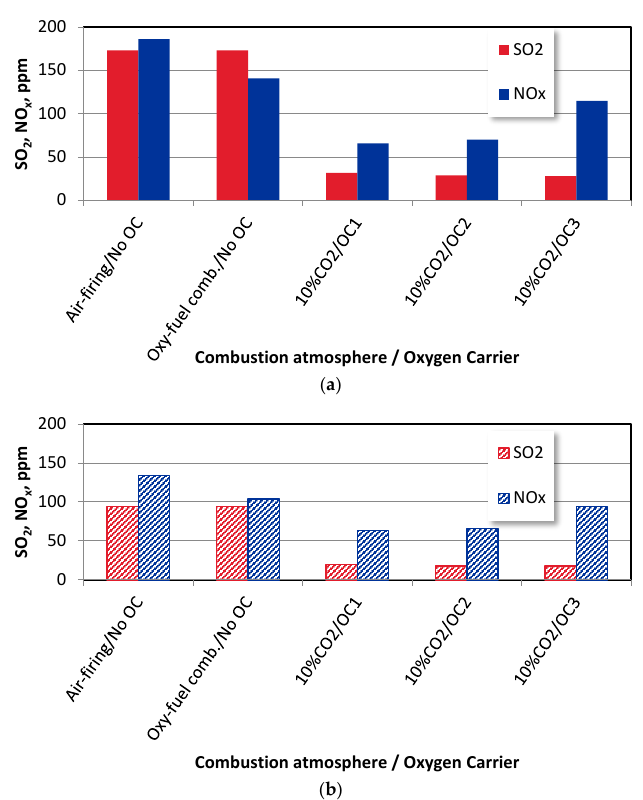
Figure 7. The SO 2 and NO x emissions from ( a ) bituminous coal and ( b ) biomass combustion under different combustion modes, where OE = 10% and T = 1080 K.